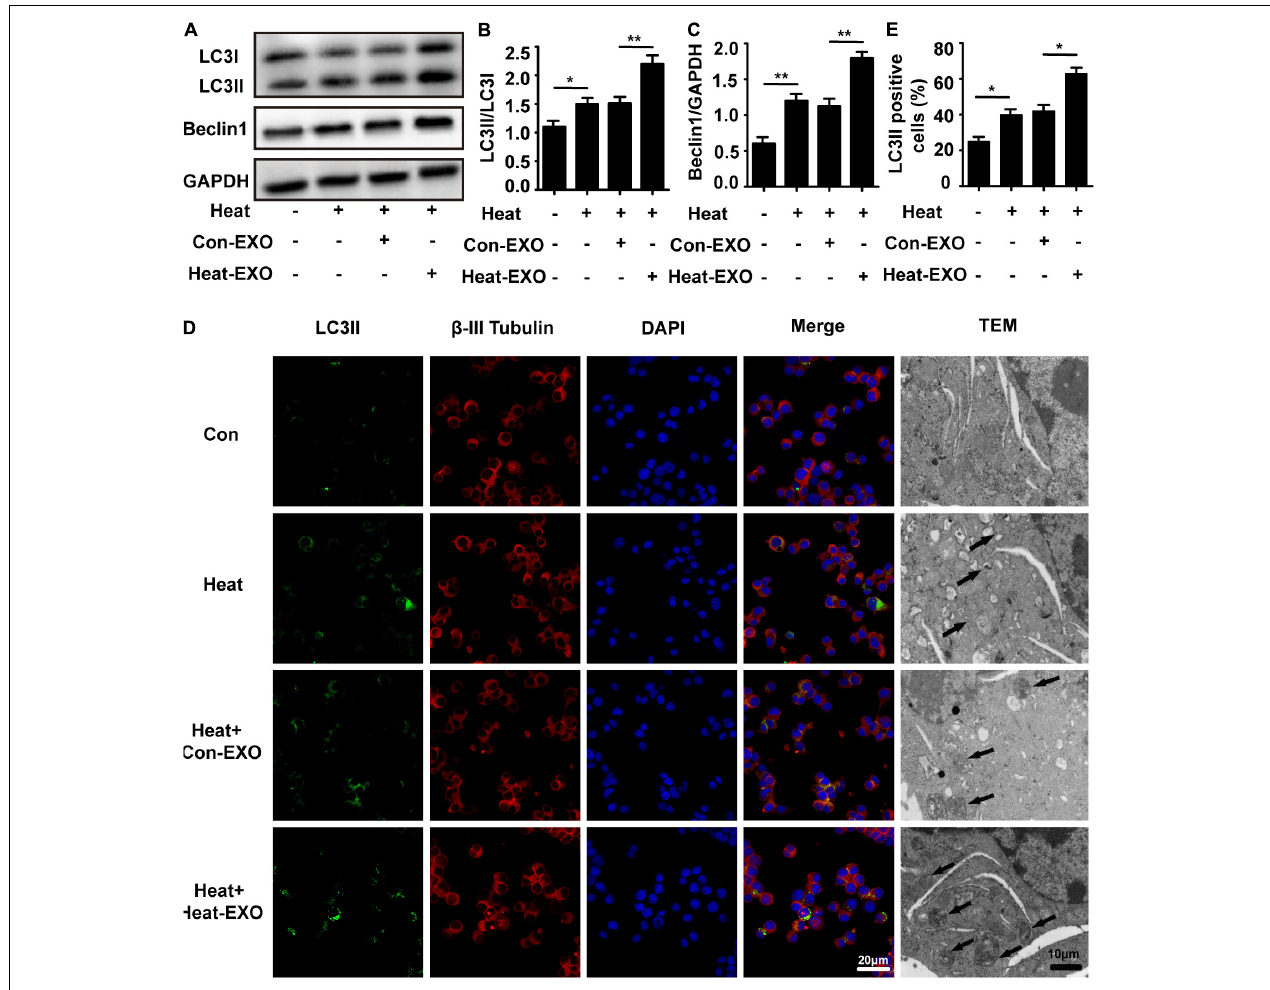
FIGURE 3 | Exosomes derived from heat stress-treated microglia greatly enhanced neuronal autophagy. N2a cells cultured alone or incubated with exosomes (50 µ g/ml) derived from sham or heat-stressed microglia for 24 h to allow enough exosomal uptake and then subjected to heat stress at 42 ◦ C for 2 h, followed by a 6 h recovery period at 37 ◦ C. (A–C) The protein expression of LC3 and Beclin-1 in N2a cells was determined by Western blotting. Densitometric analysis was performed. (D,E) The location of β -III Tubulin, LC3II, and autophagosomes in the cytoplasm of N2a cells were examined via confocal microscopy and TEM. Representative images and the analysis are shown. Con-EXO refers to exosome extracted from microglia which receives no treatment, Heat-EXO refers to exosome extracted from microglia which receives heat stress treatment. All the data are presented as the means ± SDs of at least three independent experiments. * p < 0.05; ** p <